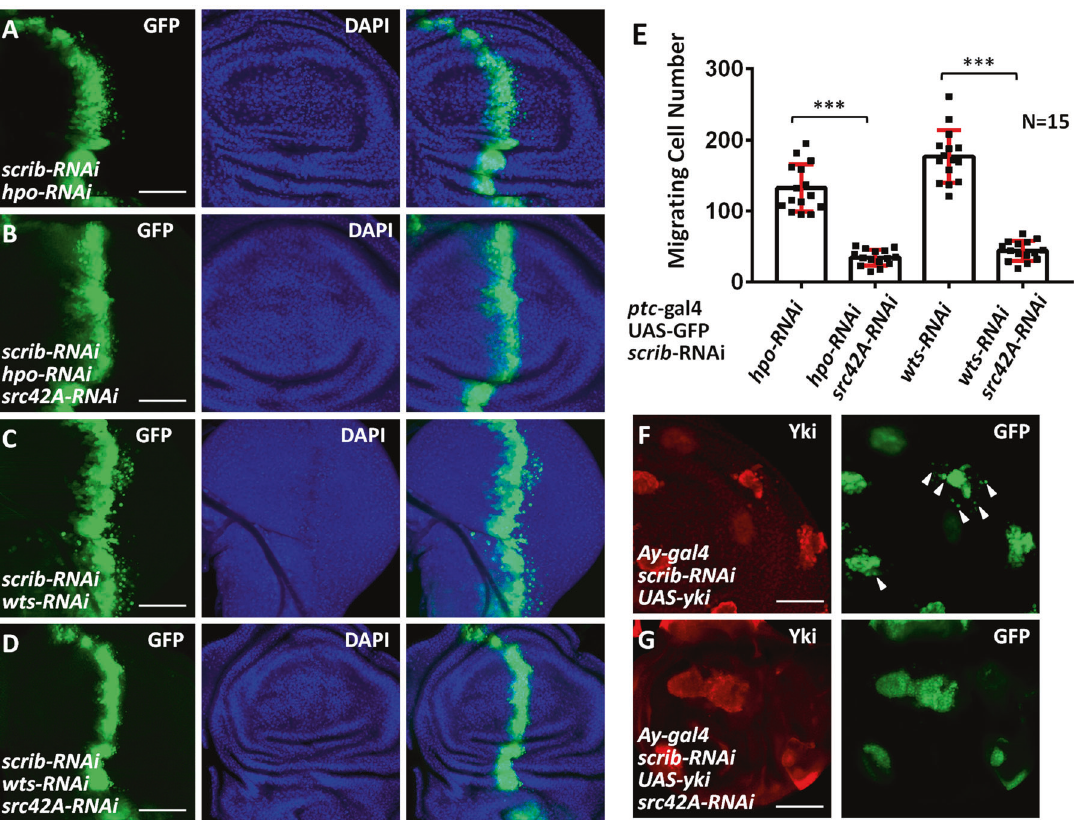
Fig. 3 Src42A is required for Yki to promote tumor cell migration. A Knockdown of hpo under scrib RNAi background caused cell migration. B Knockdown of src42A inhibited hpo -RNAi-induced cell migration under scrib RNAi background. C Silence of wts under scrib RNAi background triggered robust cell migration. D Silence of src42A decreased wts -RNAi-induced cell migration under scrib RNAi background. E Quanti fi cation of migrating cell numbers in A – D ( N = 15). Data are presented as means ± SD of values from fi fteen wing disks. F A wing disc expressing scrib RNAi and UAS- yki by Ay-gal4 was stained to show Yki (red) and GFP (green). Migrating cells are marker by arrowheads. G Knockdown of src42A suppressed Yki-induced tumor cell migration. Scale bars: 50 μ m for all